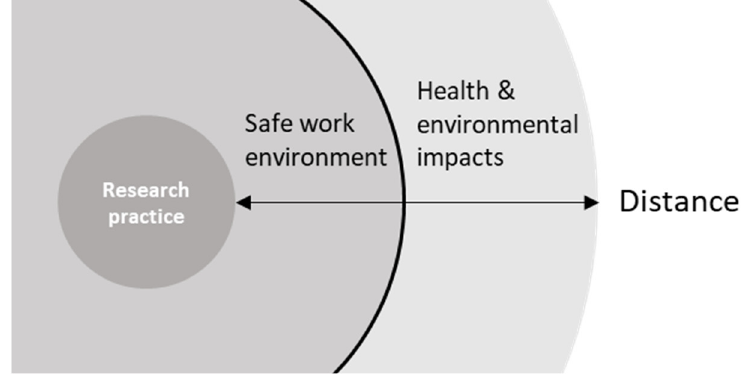
Figure 2. Identification of a boundary between work safety and downstream impacts.